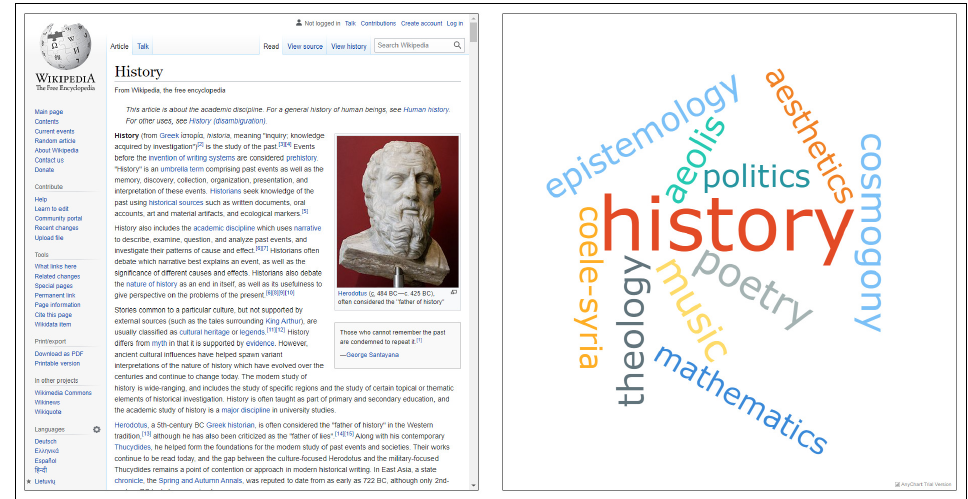
Figure 8. TagCloud visualization for the 10 most similar entities to the entity